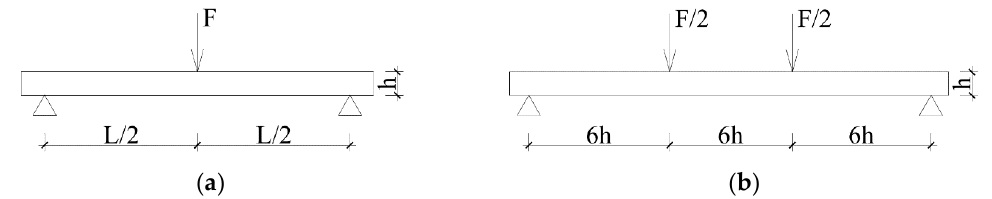
Figure 5. Scheme of testing: ( a ) small specimens Group 1, ( b ) small specimens Group 2 and technical scale beams, where F — load, L — span in bending, h — height of the beam.